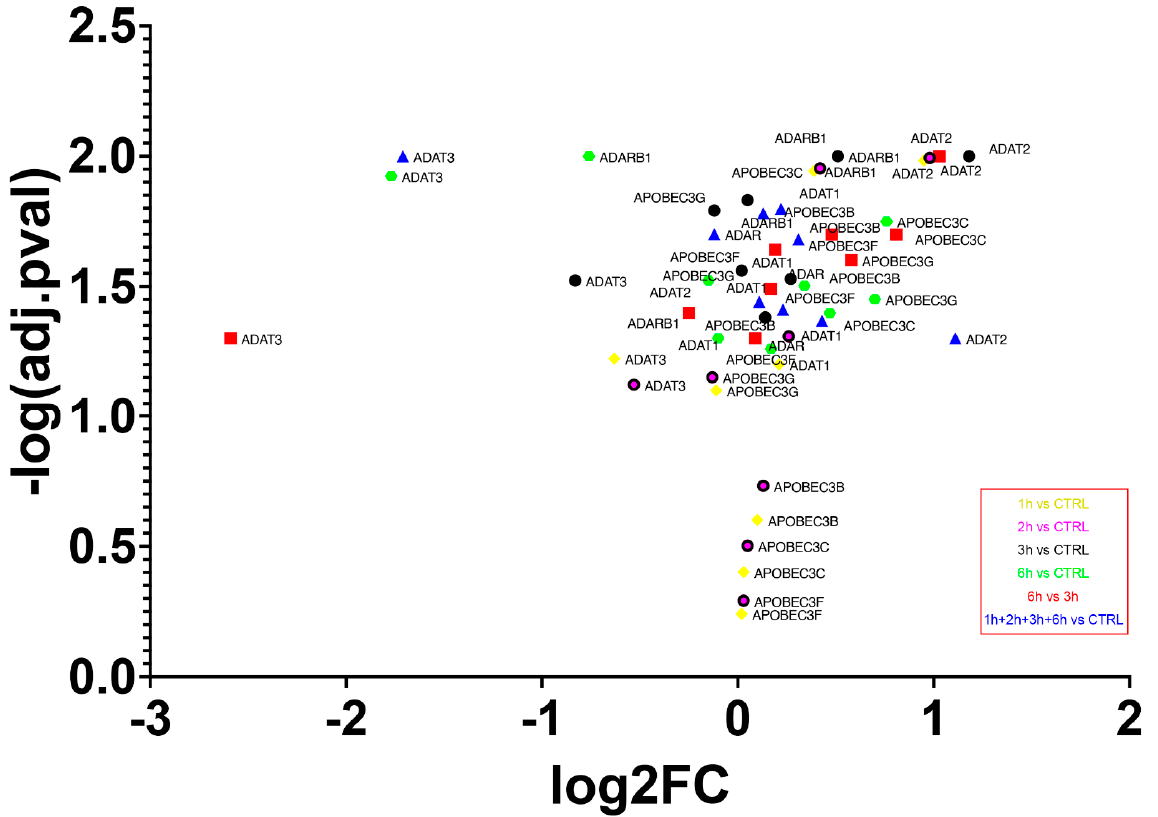
Figure 10. Expression of deaminase genes across A2E treatment. The volcano plot shows expression differences (FC) between different time points of deaminase encoding genes. All FCs for those genes were statistically significant ( p -value ≤ 0.05).